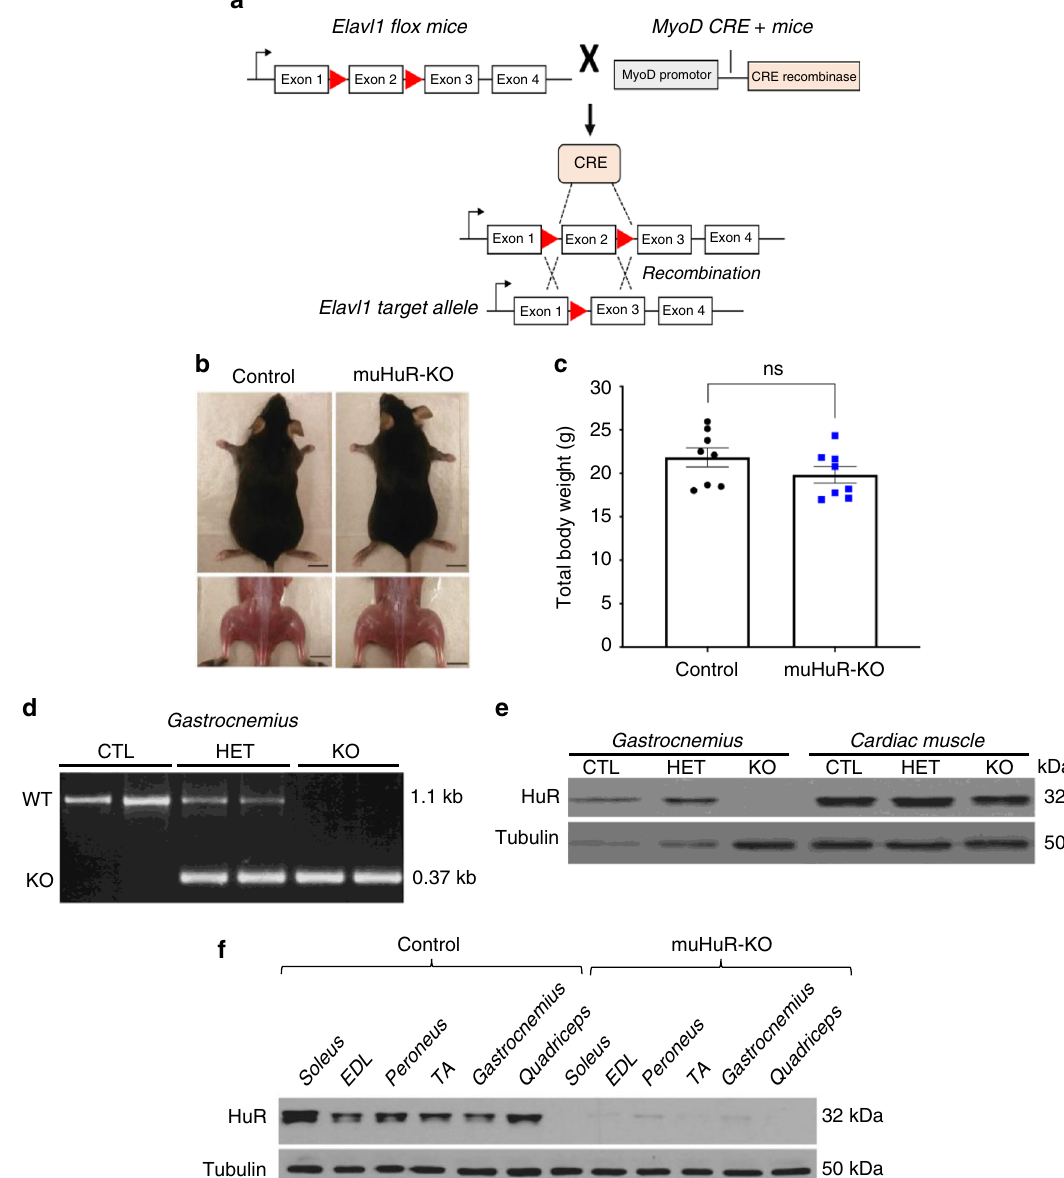
Fig. 1 Generation of HuR muscle-speci fi c knockout mice using the Cre-lox P system . a Diagram depicting the tissue-speci fi c knockout strategy. Elavl1- fl ox mice (Lox P sites ► ) were breed with mice expressing Cre recombinase under the control of the MyoD promoter (MyoD CRE + ) to generate muscle- speci fi c HuR KO mice. b Photographs of 2-month-old muHuR-KO and control male mice. Scale bars = 1 cm. c Total body weights of 8 – 10-weeks-old muHuR-KO and control mice ( n = 8). The results are presented as mean ± S.E.M, * p < 0.05 unpaired t -test. d PCR ampli fi cation of the targeted region of the Elavl1 gene in gastrocnemius muscle samples from control (CTL), heterozygote (HET), and muHuR-KO (KO) mice. Shown is a representative of agarose gel of the genotyping of all the mice used in this study ( n = 30). e Representative western blot analysis, from four independent experiments, of HuR expression in skeletal and cardiac muscle tissue from control CTL, HET, and KO mice using antibodies against HuR or α -tubulin. f Representative western blot analysis of soleus , extensor digitorum longus (EDL), peroneus , tibialis anterior (TA), gastrocnemius , and quadriceps muscles from control and muHuR-KO mice using antibodies against HuR or α -tubulin. This blot is a representative of four independent experiments. Source Data are provided in the